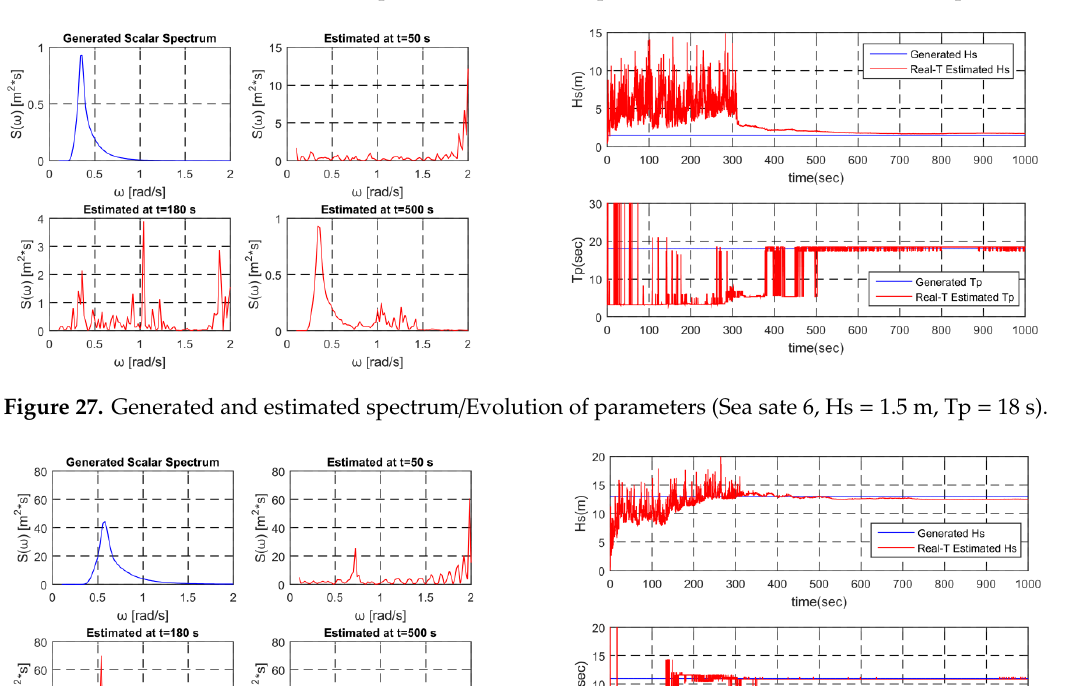
Figure 27. Generated and estimated spectrum/Evolution of parameters (Sea sate 6, Hs = 1.5 m, Tp = 18 s).